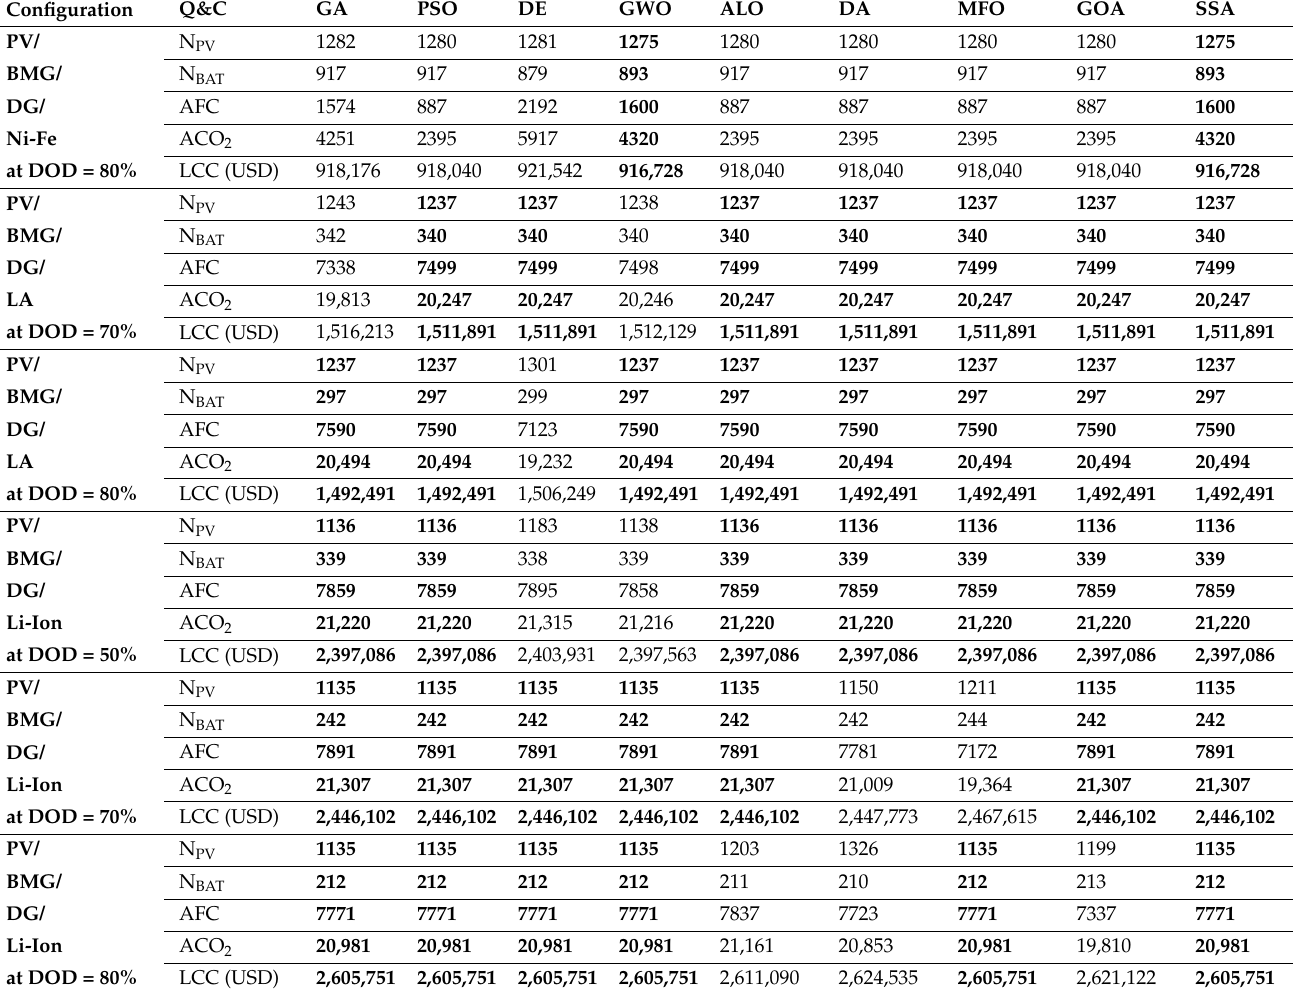
Table 8. Optimization results of the HPRALC-based IHRESs using LF strategy at LPSP value of